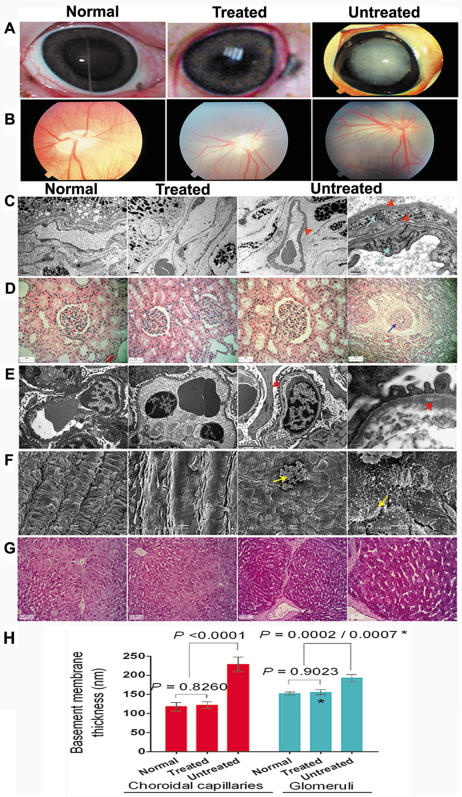
Treatment attenuated target organ injury.(A) Example of a dense cataract observed only in untreated diabetic pigs. (B) Retinal fluorescein angiography showed normal capillary permeability. (C) TEM of retina showed thickened basement membrane of a choroidal capillary, duplicated basement membrane (red arrow) and an extra layer of cells in the capillary wall (blue arrow). (D) H&E stained kidney sections showed enlarged glomeruli with mesangial expansion, and arteriolar wall thickening (arrow) in untreated diabetes. (E) TEM of untreated diabetic kidney showed thickening of glomerular basement membrane. (F) SEM showed abnormal endothelial surface structures only in carotid arteries of untreated diabetic pigs. (G) Increased intensity of PAS staining in untreated diabetic liver without fibrosis or cirrhosis. (H) Basement membrane thickness, measured in 20 choroidal capillaries and 20 renal glomeruli of each group (n = 2), was significantly greater in untreated diabetes cf. both treated and healthy animals. *, treated vs. untreated.